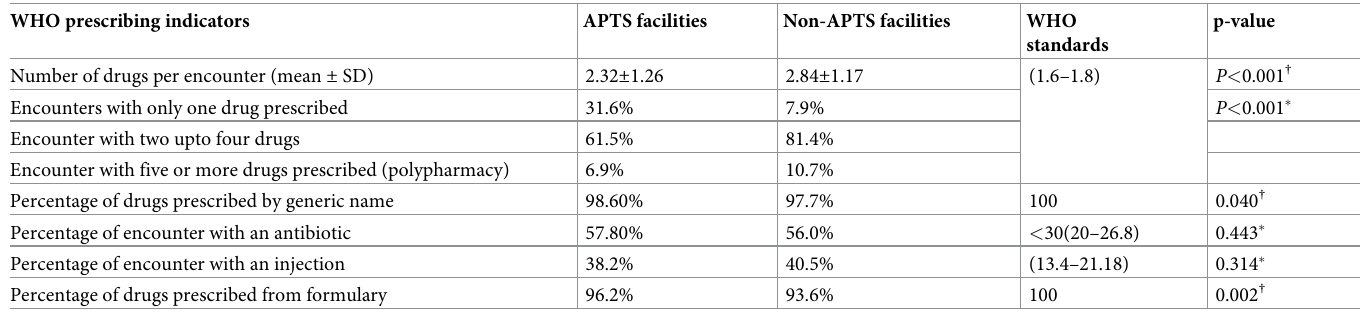
Table 5. Comparison of the WHO prescribing indicators between encounters/ drugs of APTS and Non-APTS